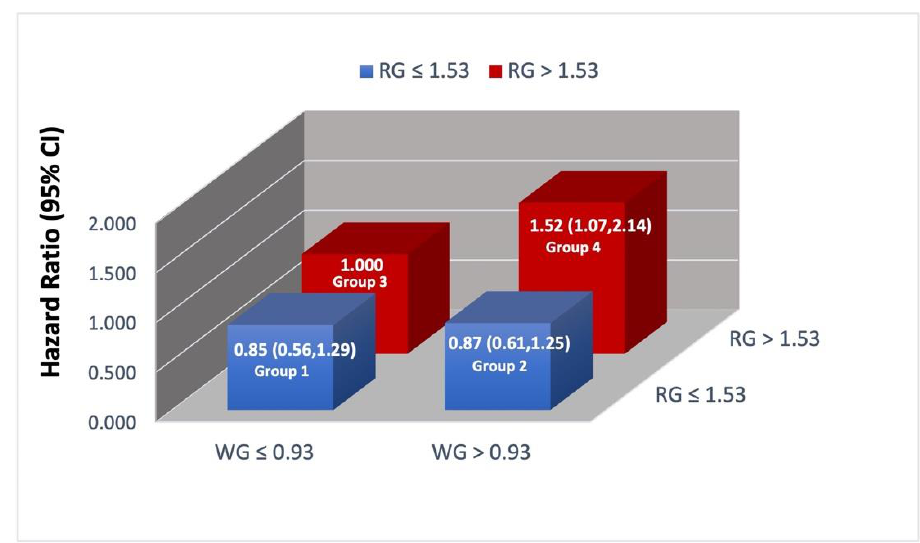
Figure 2. Joint associations of whole grains and refined grains with total mortality. The hazard ratios presented in this chart were adjusted for age at diagnosis, smoking status, menopause status, physical activity, body mass index, total calorie and protein intake, and cancer characteristics, namely chemotherapy, radiation therapy, cancer stage, and hormone status. Abbreviations: RG = refined grains; WG = whole grains.